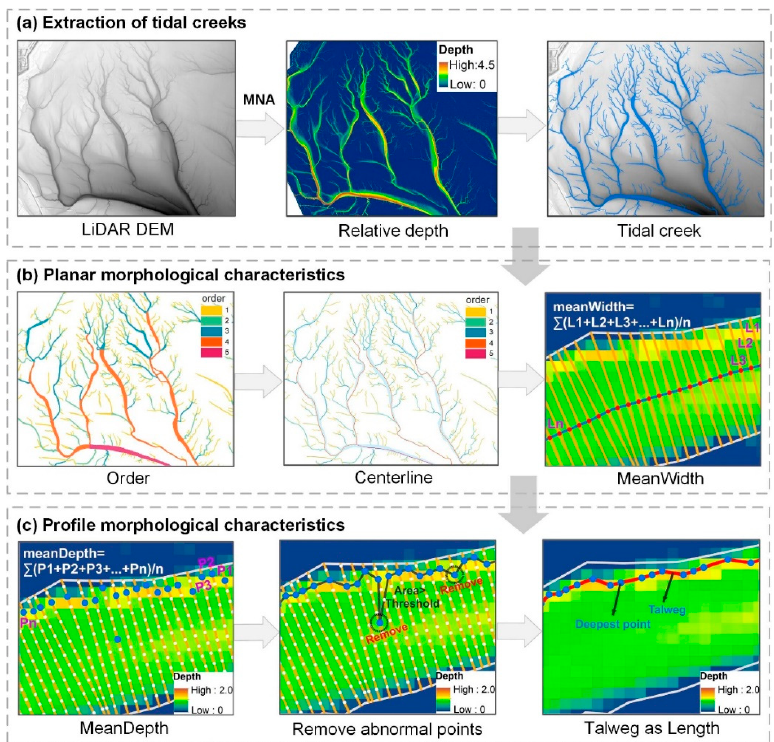
Figure 4 . Flowchart illustrating the steps using a LiDAR DEM to extract the morphological Figure4. FlowchartillustratingthestepsusingaLiDARDEMtoextractthemorphologicalcharacteristics characteristics of tidal creeks in this study. of tidal creeks in this